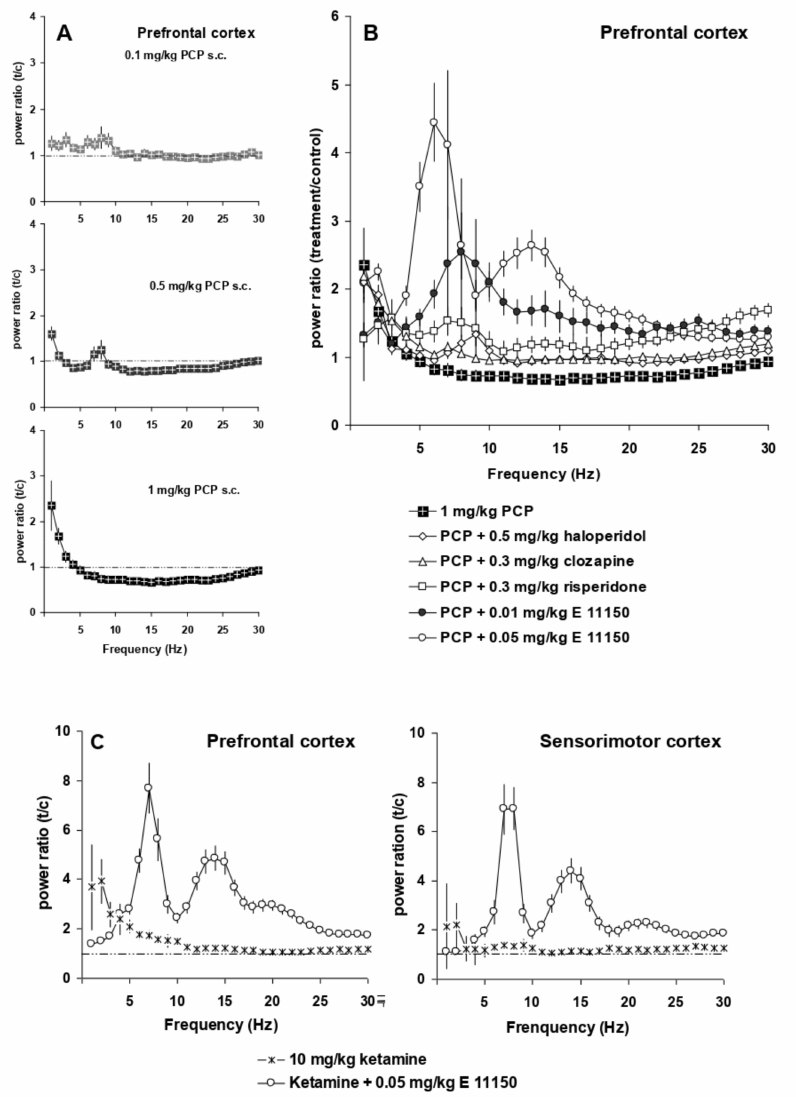
Figure 4. Interaction of antipsychotic compounds with NMDA antagonists in the prefrontal cortex. Panel ( A ) EEG power spectra induced by increasing doses of PCP. Panel ( B ) Composite graph of power spectra (total power) of 1 mg/kg s.c. PCP, as well as 0.3 mg/kg s.c. clozapine, 0.5 mg/kg i.p. haloperidol, 0.3 mg/kg i.p. risperidone, 0.01 mg/kg i.p. EGIS 11150, 0.05 mg/kg i.p. EGIS-11150 in the presence of PCP. Panel ( C ) Power spectra (total power) of the prefrontal and sensorimotor cortex of 10 mg/kg i.p. ketamine and 0.05 mg/kg i.p. EGIS-11150 in the presence of ketamine ( n =